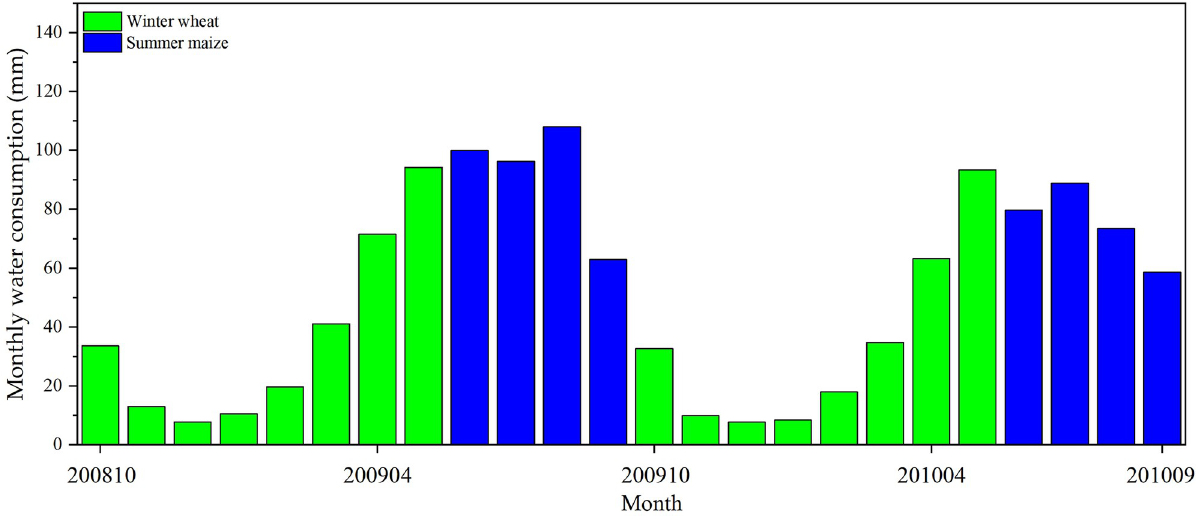
Fig 6. Monthly water consumption for winter wheat and summer